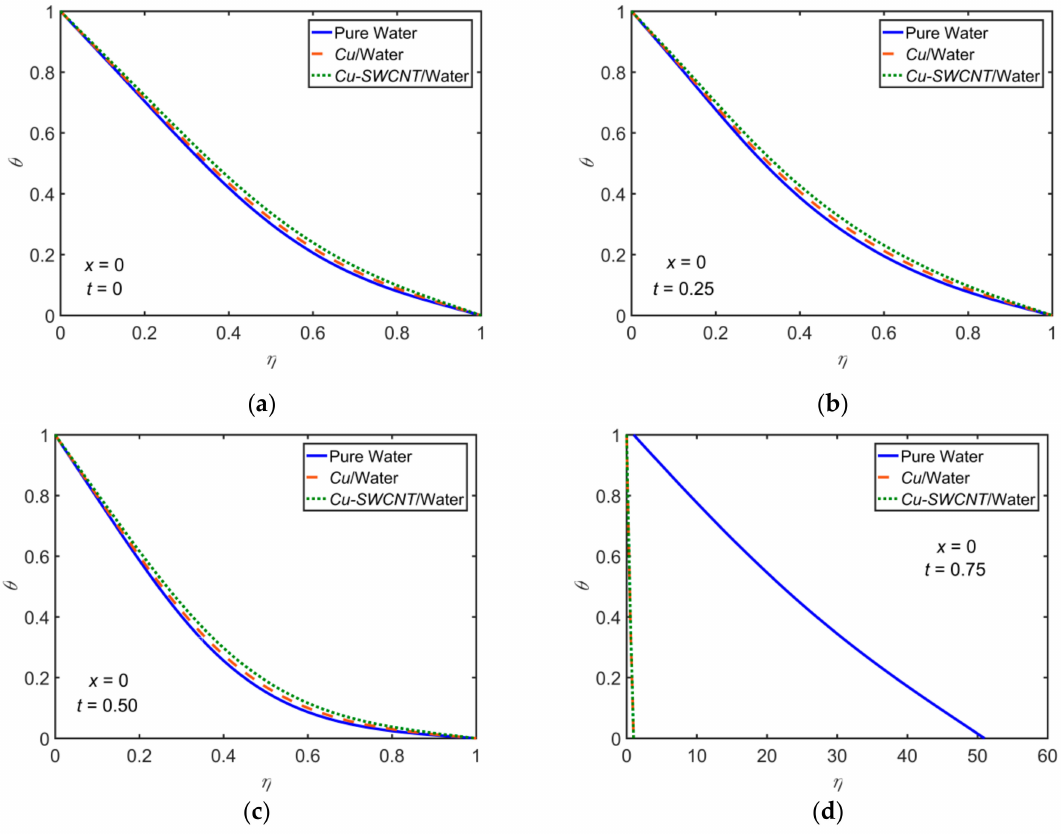
Figure 6. Comparison of pure water, Cu /water, and Cu – SWCNT /water for the temperature profiles for M = 5, Pr = 1, Rd = 0.2, Re = 700, and φ = 0.02 at ( a ) t = 0, ( b ) t = 0.25, ( c ) t = 0.50, and ( d ) t =